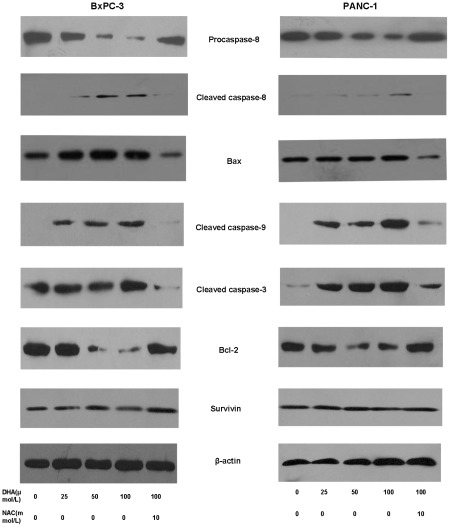
The expression of apoptosis-related genes.BxPC-3 and PANC-1 cells were treated with various concentrations of DHA (0, 25, 50, 100 µmol/L) and pretreated with NAC followed by DHA (100 µmol/L) for 72 h. Whole cell extracts were prepared and analyzed by western blotting using antibodies against Bcl-2, Bax, surviving, caspase-3, caspase-8, and caspase-9. DHA significantly up-regulated the expression of Bax, caspase-3, caspase-8 and caspase-9, and down-regulated the expression of Bcl-2. However, DHA had little influence on the expression of survivin. DHA with NAC (10 mM) pretreatment did not up-regulate the expression of caspase-8, Bax, caspase-9, and caspase-3. β-actin served as an internal control.